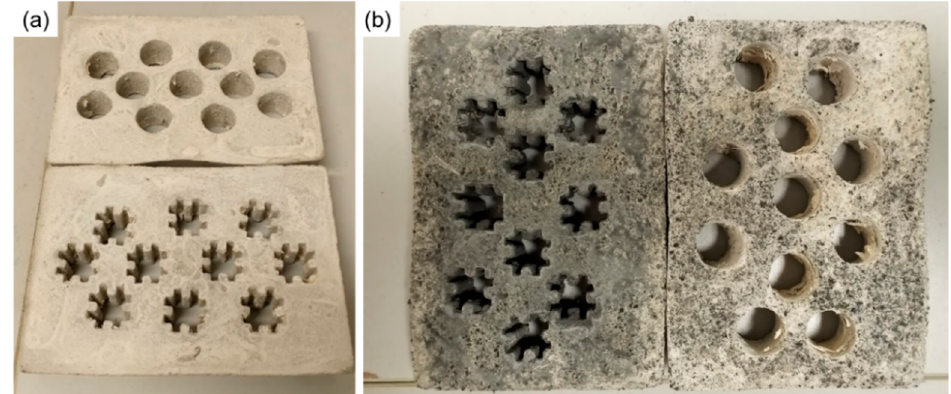
Figure 12. CHD and FHD hollow-brick prototypes: ( a ) REF mix and ( b ) RuC mix.